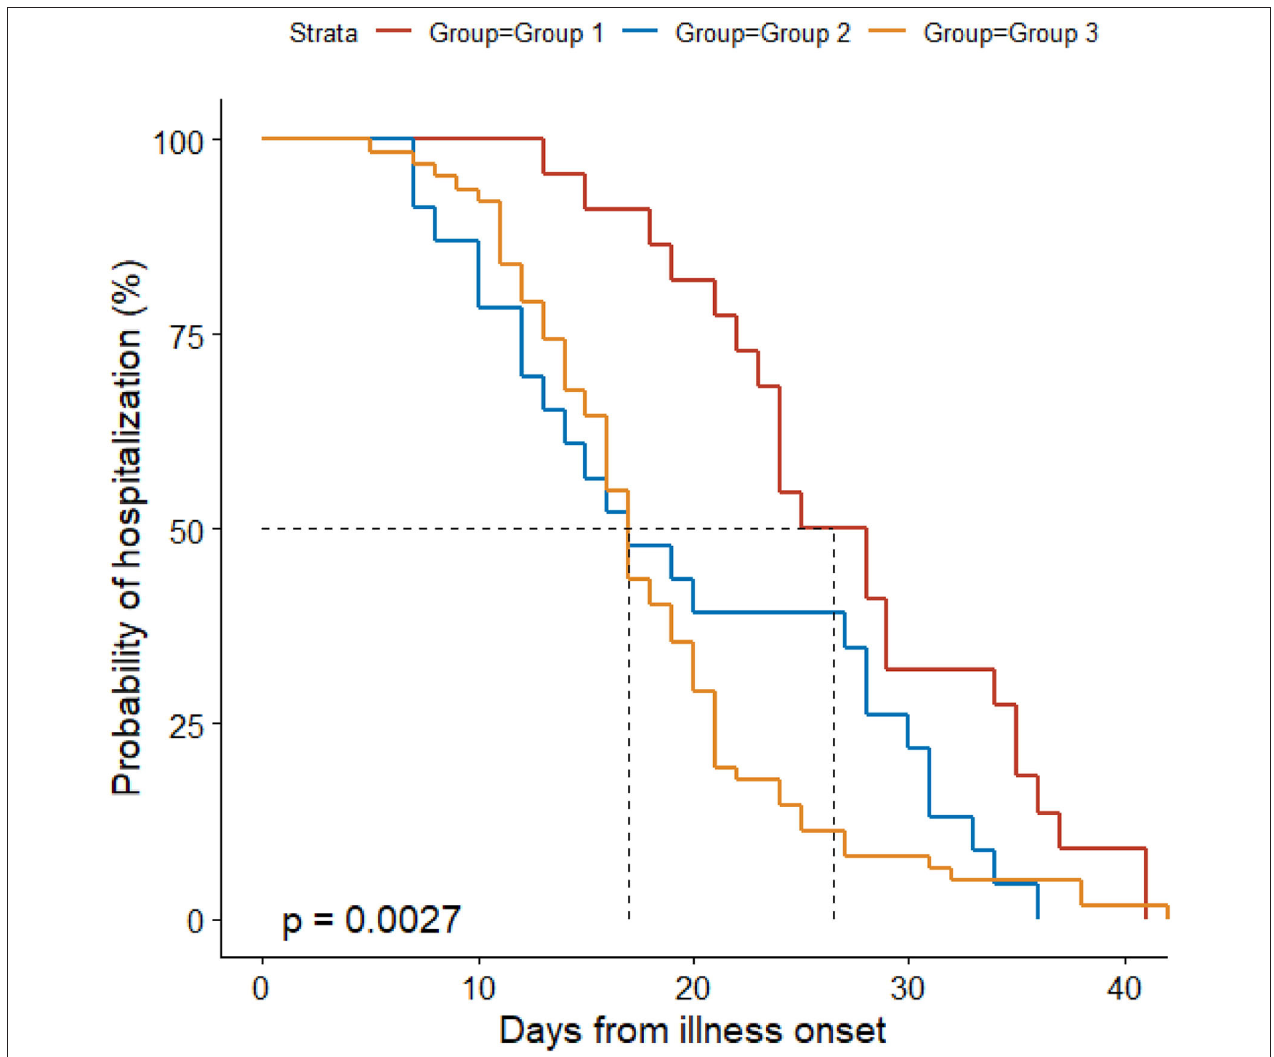
FIGURE 1 | Probability of hospitalization by duration from illness onset in the three groups. Patients in Group 1 were confirmed to have COVID-19 and excluded from other pathogen infections; individuals in Group 2 had clear exposure history, symptoms, and typical CT findings for COVID-19, but they tested negative for SARS-CoV-2 RNA and other respiratory pathogens throughout the disease course; we further included patients with other non-COVID-19 pneumonia as Group 3, who did not have an exposure history and tested negative for SARS-CoV-2 RNA throughout the disease course, and who had symptoms and positive CT findings suggesting